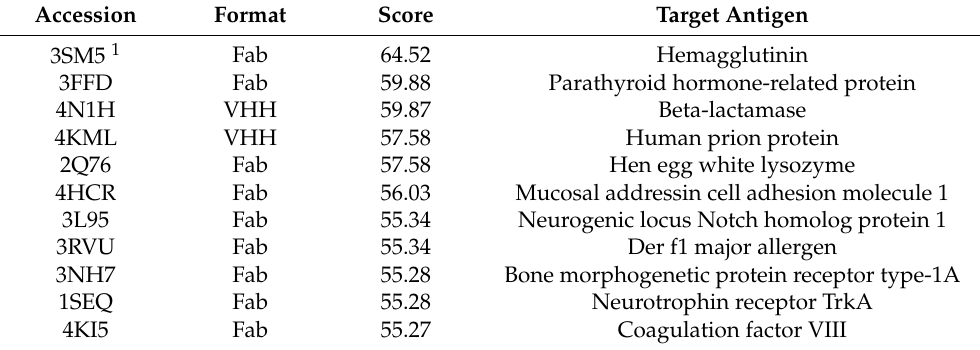
Table 2. Variable domains of the PDB (version 15 April 2015) similar to nanobody 238D2, with score above